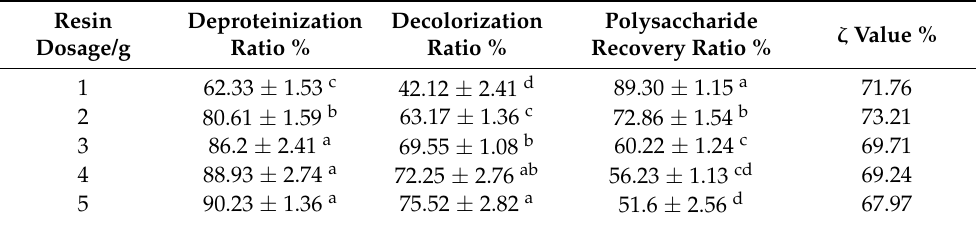
Table 4. Effect of resin dosage on decoloration ratio, deproteinization ratio, polysaccharide recovery ratio, and selectivity coefficients of A-722MP resin.